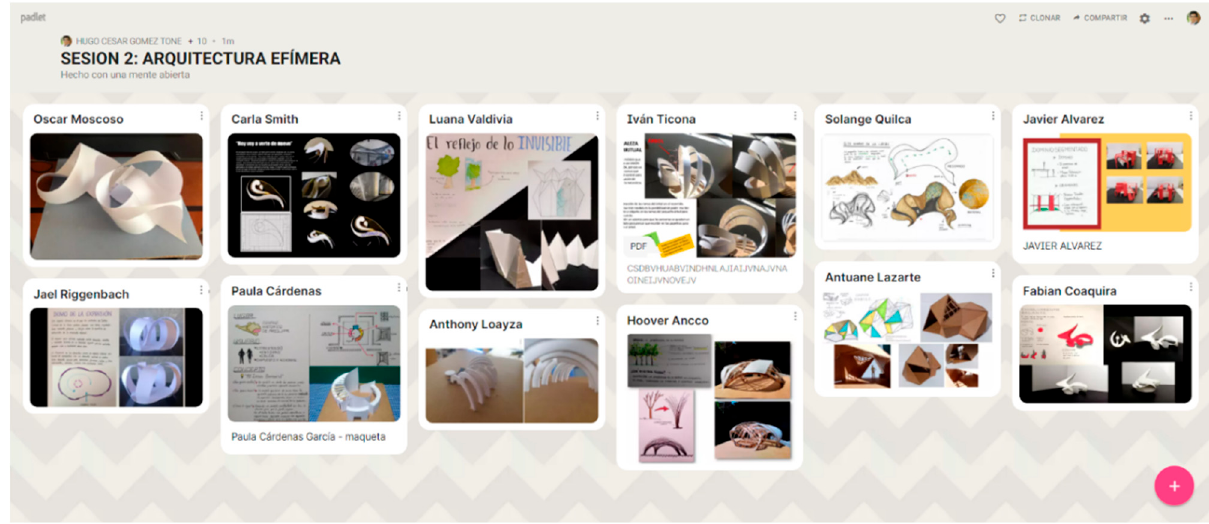
Figure 4. The second phase: a schematic design by the 12 students, using the traditional method.